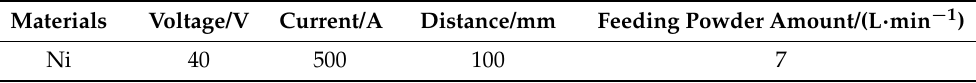
Table 1. Plasma spraying parameters.